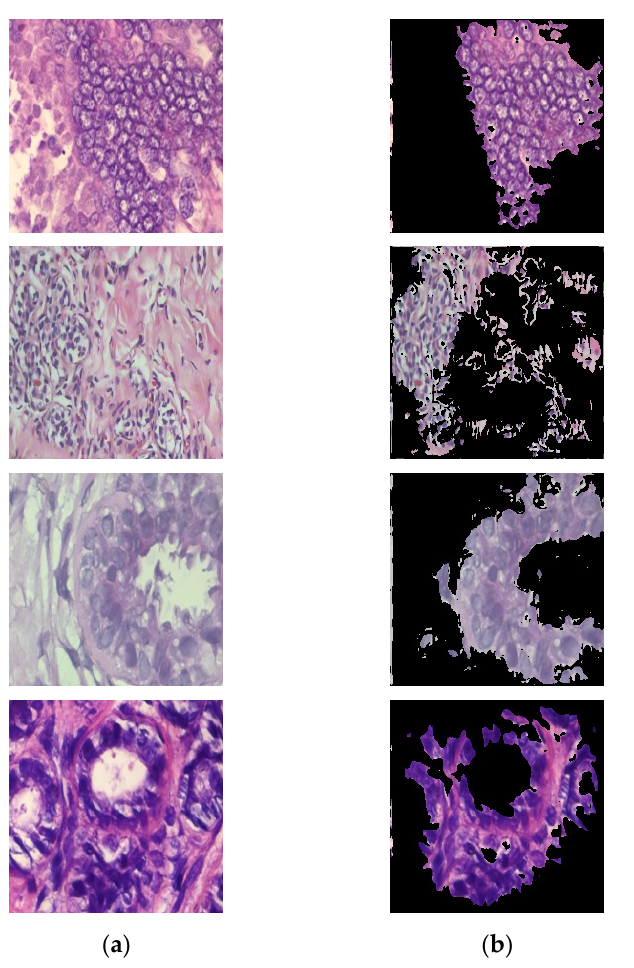
Figure 10. The segmentation results of the proposed method: ( a ) the input images; ( b ) segmented results of our